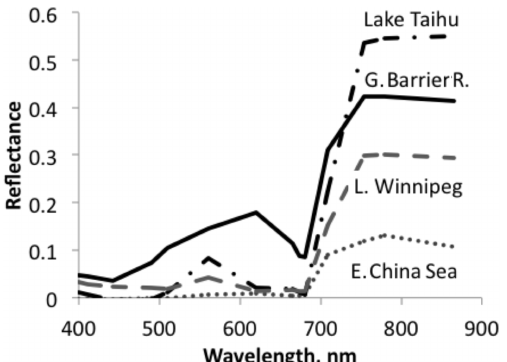
Figure 4. Ocean reflectance over 1 radian according to Li et al. (2021) for various concentrations of chlorophyll- a -containing organisms. Creative Commons Attribution (CC BY) license (https: //creativecommons.org/licenses/by/4.0/, last access: 6 February